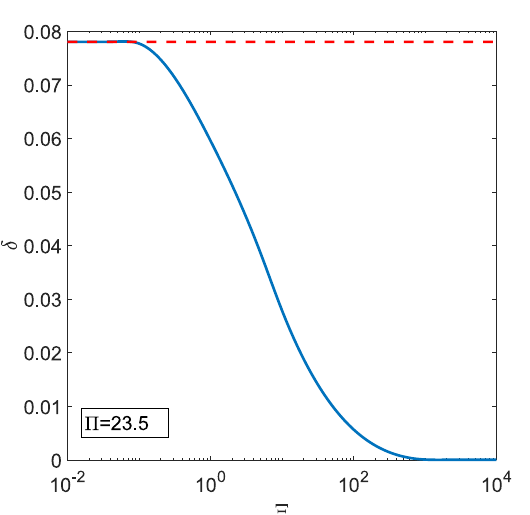
Figure 5. The dimensionless dissipated work δ as a function of the frequency Ξ for a fixed value of Π = 23.5. The blue lines refers to results obtained by means of the viscoelastic reciprocating approach, whereas the red dotted line is obtained employing a classic steady-state